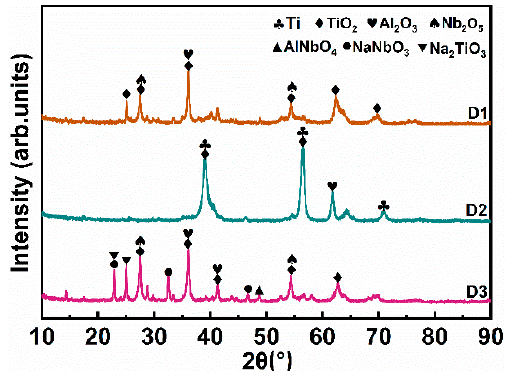
Figure 4. XRD patterns of all tested samples.